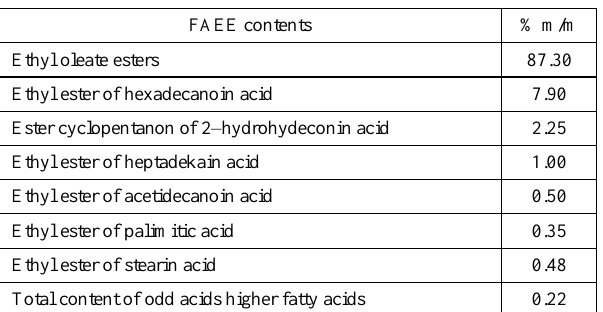
Table 2. Average content of FAEE